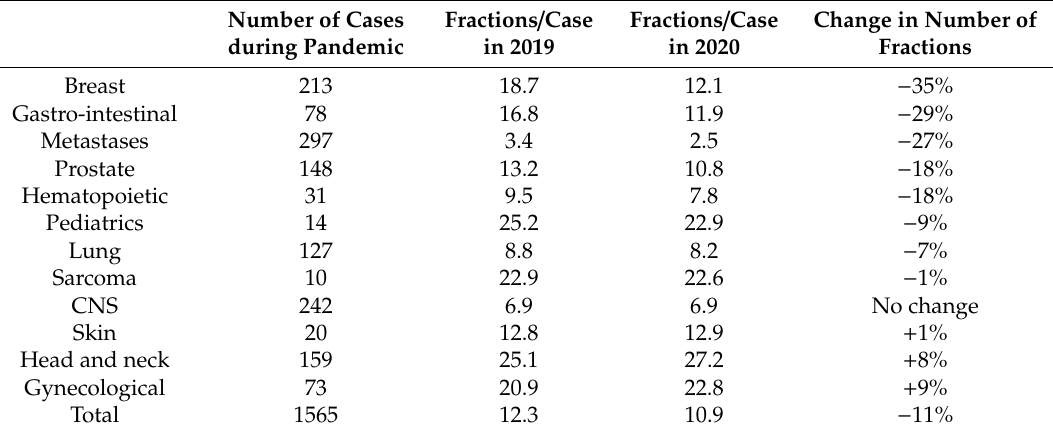
Table 2. Fractionation.